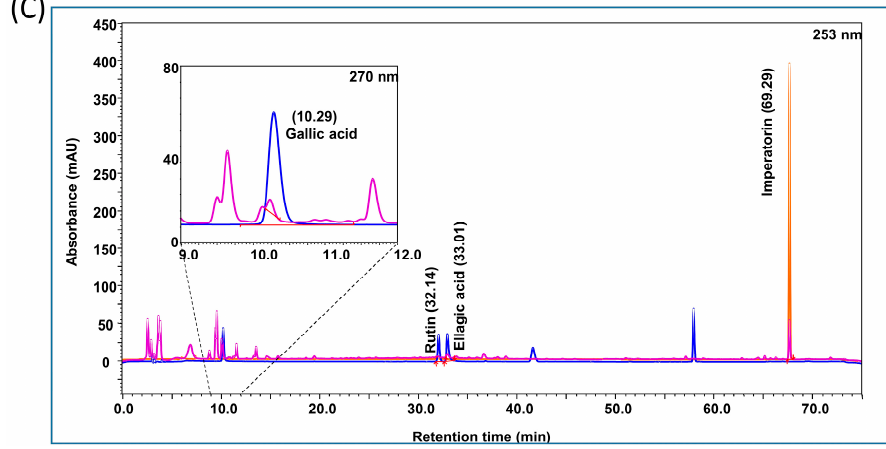
Figure 5. UV absorbance spectroscopy and phytochemical profiling study of in vitro digested EC Cologrit tablets. UV absorbance scan between the 300–400 nm range was done to validate the solubilization of the Cologrit tablet at various time-points. The solubilization of the tablets in ( A ) stomach phase, and ( B ) intestinal phase was evaluated using λ max analysis at 339 nm. ( C ) HPLC analysis of the 120 min Intestinal phase solubilized EC Cologrit tablets revealed the presence of Gallic acid (retention time 10.29 min), Rutin (retention time 29.61 min), Ellagic acid (retention time 30.60 min), and Imperatorin (retention time 68.09 min). Table 4 displays their phytochemical concentrations. All experimental conditions were repeated thrice. Statistical analysis was performed using one-way ANOVA followed by Dunnett’s posthoc test. * p -value < 0.05; ** p -value < 0.01 (0 min versus incubation treatment).